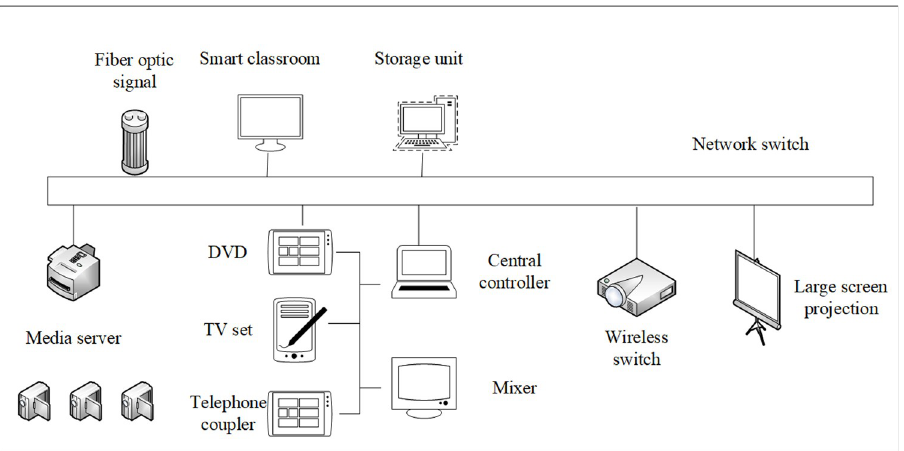
Fig 8. Sub-end topology of the integrated platform of smart classroom teaching